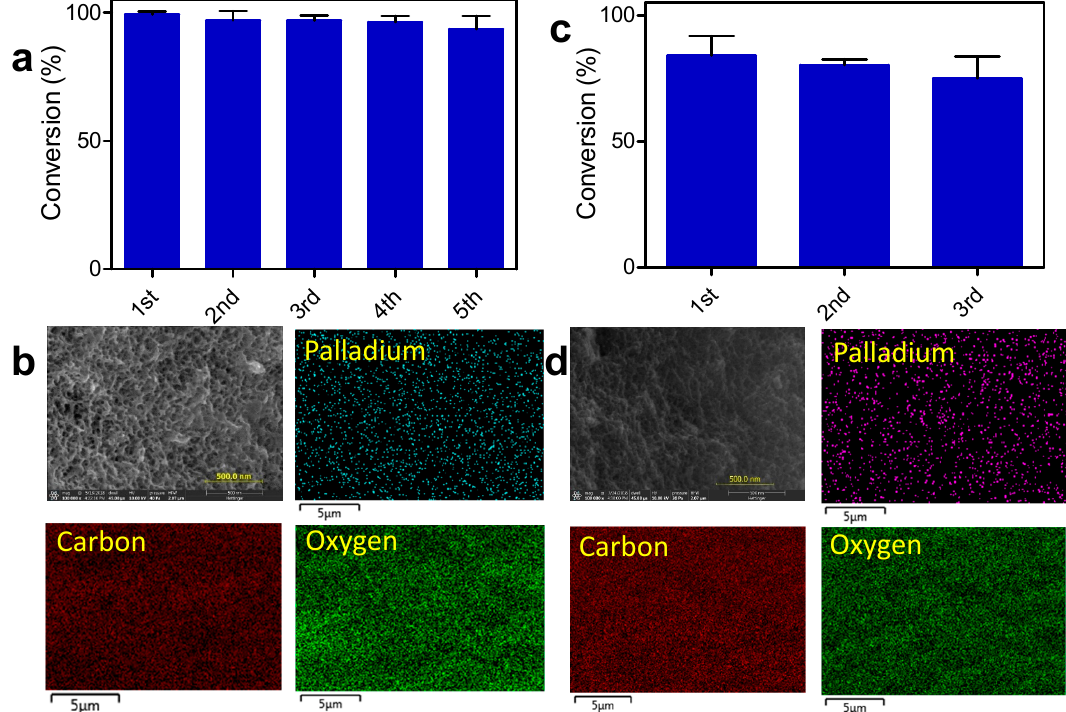
Figure 7. (a) Suzuki- Miyaura reaction conversion rate in batch system for Iodotoluene with Figure 7. ( a ) Suzuki-Miyaura reaction conversion rate in batch system for Iodotoluene with ethanol as ethanol as solvent for 5 reaction cycles (n=3), (b) SEM, and the corresponding EDS elemental solvent for 5 reaction cycles (n = 3), ( b ) SEM, and the corresponding EDS elemental mapping analysis mapping analysis for used MPR110-EW-P3 3% after 5 runs in ethanol-water as solvent (c) Suzuki- for used MPR110-EW-P3 3% after 5 runs in ethanol-water as solvent ( c ) Suzuki-Miyaura reaction Miyaura reaction conversion rate in batch system for Bromotoluene and DMF as solvent for 3 conversion rate in batch system for Bromotoluene and DMF as solvent for 3 cycles (n = 3), ( d ) SEM, cycles (n=3) , (d) SEM, and the corresponding EDS elemental mapping analysis for used MPR110- and the corresponding EDS elemental mapping analysis for used MPR110-EW-P3 after 3 cycles with EW-P3 after 3 cycles with DMF- water solvent. DMF—water